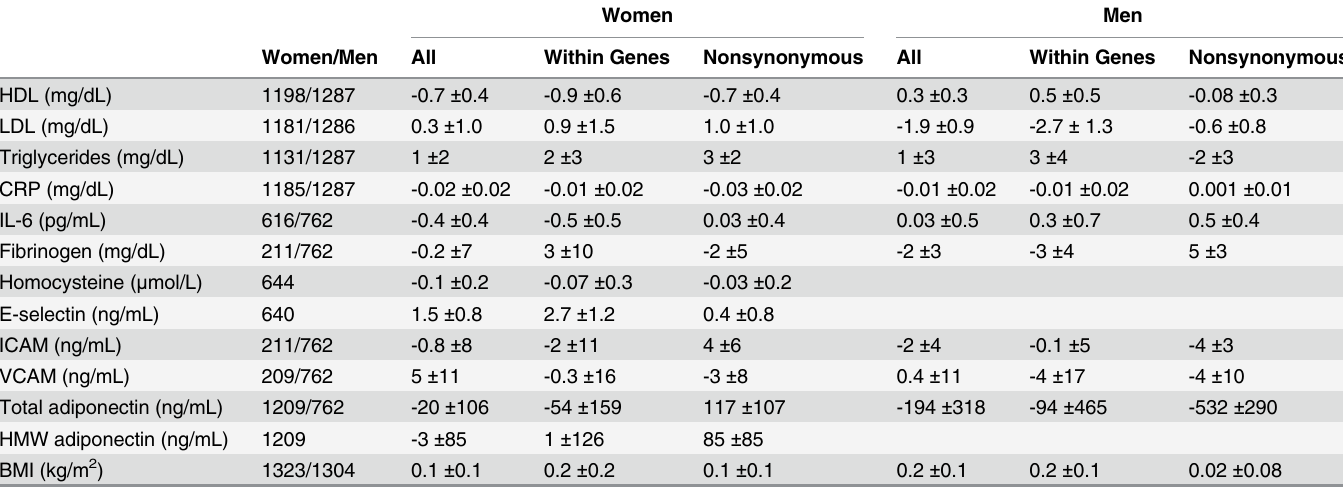
Table 2. Association of CHD risk factors with overall heterozygous loci, loci within genes, and nonsynonymous